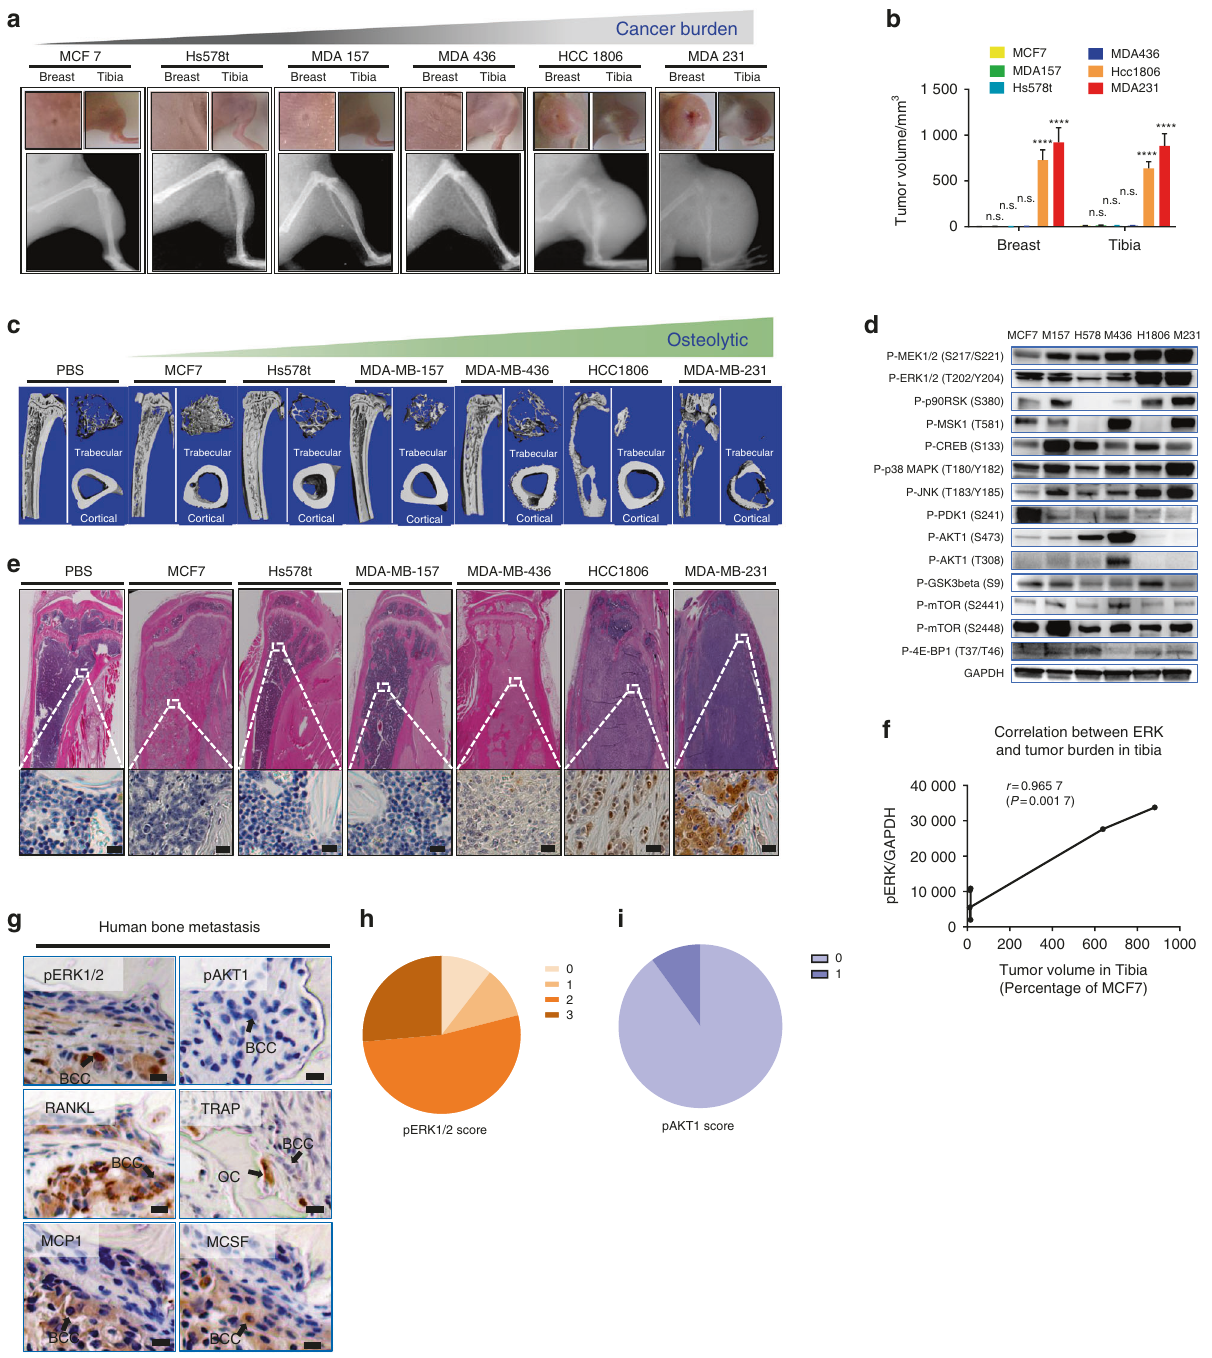
Fig. 1 Activation of ERK1/2 by breast cancer cells is correlated with metastatic tumor burden in bone. a MDA231 or HCC1806 breast cancer cells displayed more aggressive bone destruction and greater tumor size than MDA436, Hs578t, MDA157 and MCF7 cells ( n = 3; at 4 weeks following intratibial injection). b Tumor growth within murine tibia and breast tissue secondary to breast cancer cell line introduction. Statistical analysis was performed by one-way ANOVA with Dunnett ’ s multiple comparisons. c Micro-CT imaging revealed that breast cancer cells metastatic to bone demonstrate a purely osteolytic phenotype. Imaging was performed in PBS on the HCC1806 and MDA231 groups 4 weeks following intratibial injection; imaging for the MCF7, Hs578t, MDA157, and MDA436 groups was performed at 12 weeks following intratibial injection. d Con fi rmation by Western blot analyses. e A representative IHC image showing ERK1/2 activation in BCCs adjacent to an osteolytic lesion. f Correlation between ERK1/2 activation and cancer growth in bone. g Histologic analysis demonstrated that ERK1/2 activation in BCCs metastatic to bone is associated with increased production of osteoclastogenic cytokines and chemokines. pERK1/2 + BCCs are indicated by the presence of arrows. Scale bar: 20 μ m. h Quanti fi cation of pERK1/2 + BCCs in human breast cancer bone metastases. Seventeen of 19 (89.5%) lesions positively stained for pERK1/2 in BCCs. Five (26.3%) of these lesions earned scores of 3, indicating strong, complete membrane staining in >10% of cells, 10 (52.6%) earned scores of 2, indicating weak to moderate strength, complete staining in >10% of cells, and 2 (10.5%) lesions garnered a score of 1, indicative of weak and partial staining in >10% of cells, with respect to pERK1/2 microenvironmental signal intensity. i Quanti fi cation of pAKT1 + BCCs in human breast cancer bone metastases. One of 10 (10%) lesions positively stained for pERK1/2 in BCCs, with a score of 1 according to the aforementioned scoring